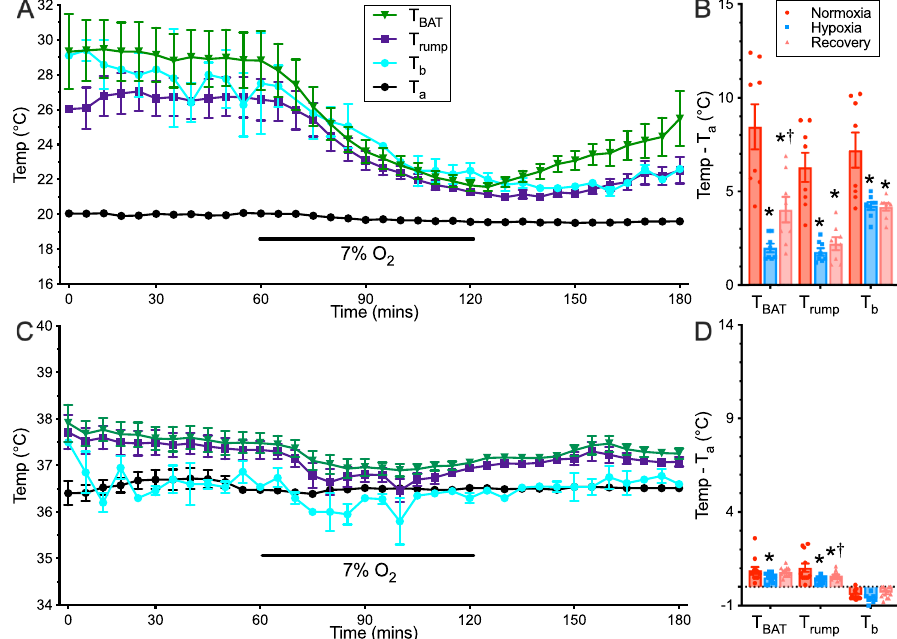
Fig. 2 Naked mole-rats actively thermoregulate in cold, but not hot temperatures. A , C Summaries of ambient temperature ( T a , black circles), core body temperature ( T b , teal circles), interscapular brown adipose tissue temperature ( T BAT , green triangles), and dorsal skin surface temperature ( T rump , blue squares) from naked mole-rats exposed to a normoxia → hypoxia → recovery protocol in 20 °C ( A , n = 8 independent animals), or 36 °C ( C , n = 12 independent animals). B , D Summaries of temperature difference between physiological temperatures and T a at 20 °C ( B ) or 36 °C ( D ) from data presented in ( A ) and ( C ), respectively. Data are mean ± SEM. Asterisks indicate a signi fi cant difference from normoxic controls; daggers indicate signi fi cant difference from hypoxia (repeated measures ANOVA with Tukey post-test; F 2,15 = 29.89, p < 0.0001 for 20 °C, F 2,22 = 6.63, p = 0.0113 for 30 °C). Source data are provided as a Source Data fi